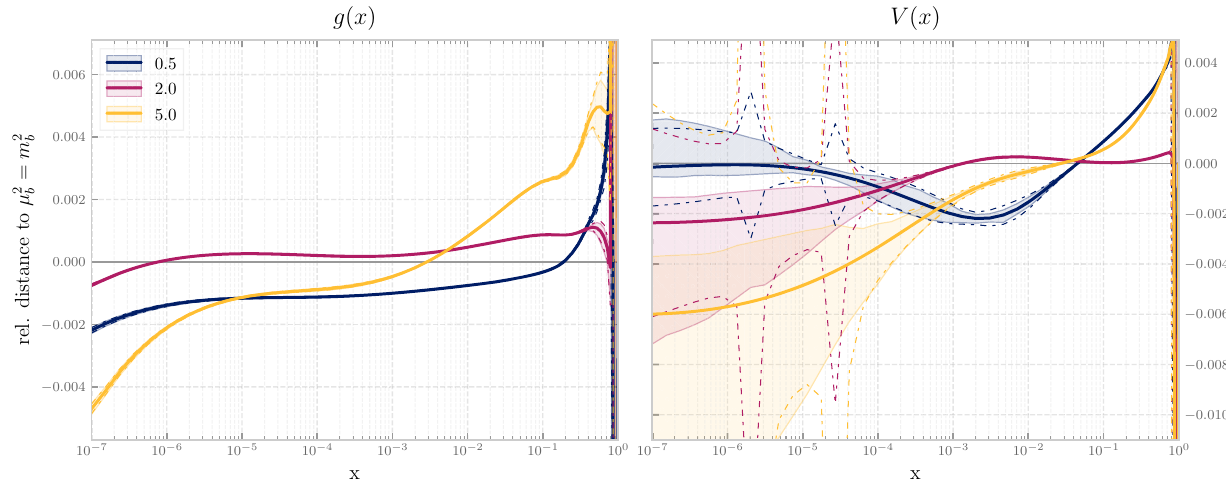
= m 2 relative to μ 2 . Note the different b b b